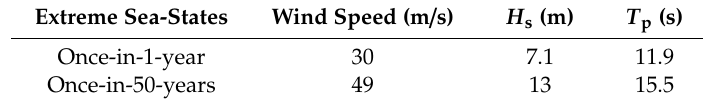
Figure 10. Mooring configuration of SFOWT. Table 7. Environmental loads under extreme sea-states.